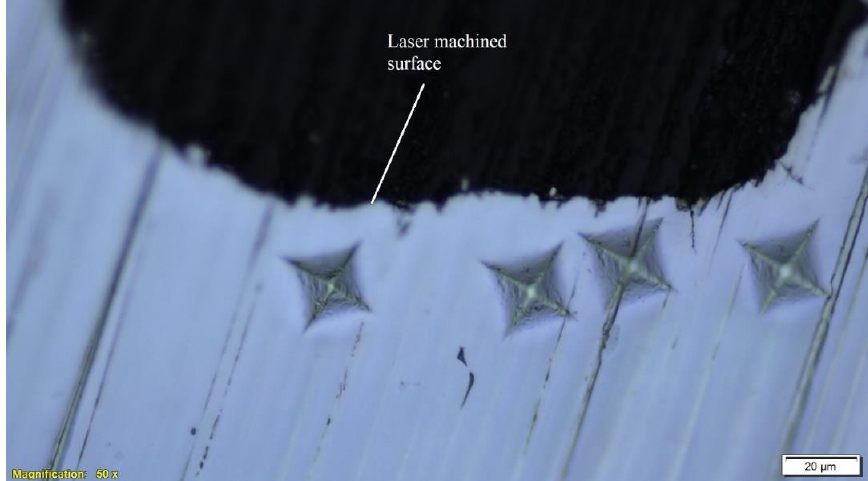
Figure 11. Microhardness indentations beneath the laser machined microchannel.